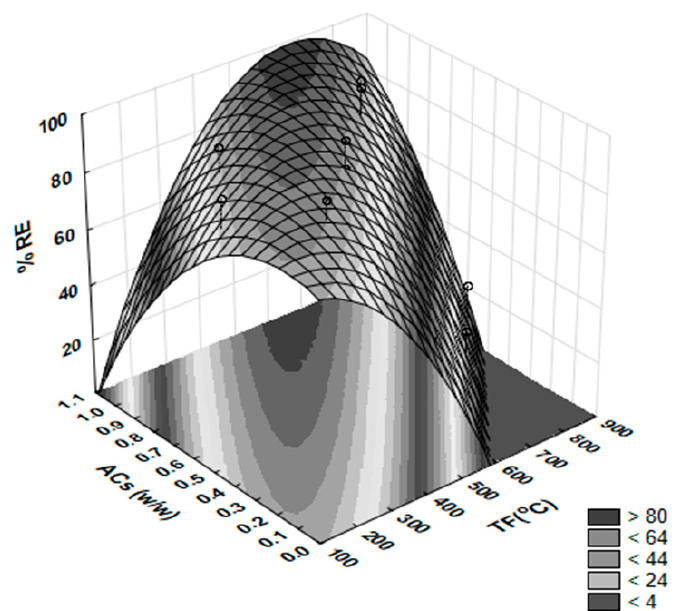
Figure 14. Response surface plot and contour lines for %RE (REE extraction) versus TF (roasting temperature) and ACs (Acid/sample mass ratio)—Equation (11) (leaching time—tL = 20 min).